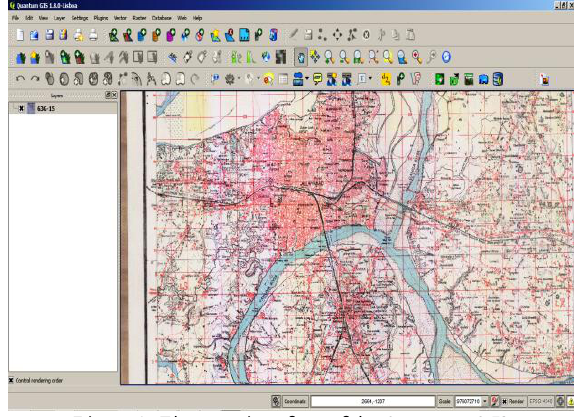
Figure 3: The user interface of the Quantum GIS Quantum GIS provides features like map navigation, attribute